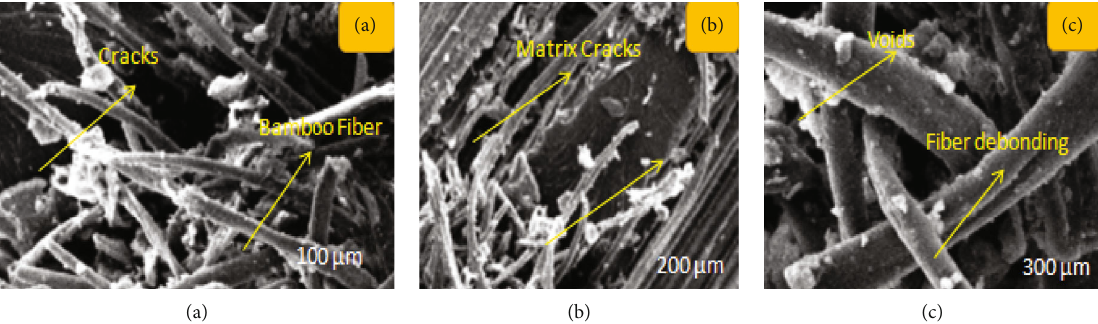
Figure 9: Micrographic images for fl exural fractured surfaces of samples (a) 10% (b) 15%, and (c)